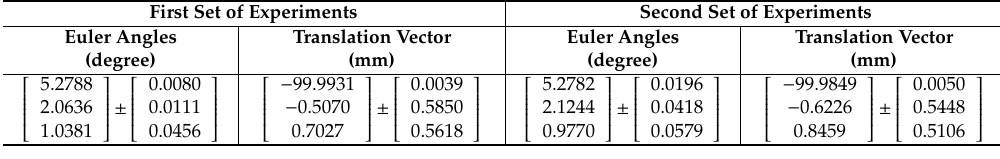
Table 2. The mean and standard deviation of Euler angles and translation vectors